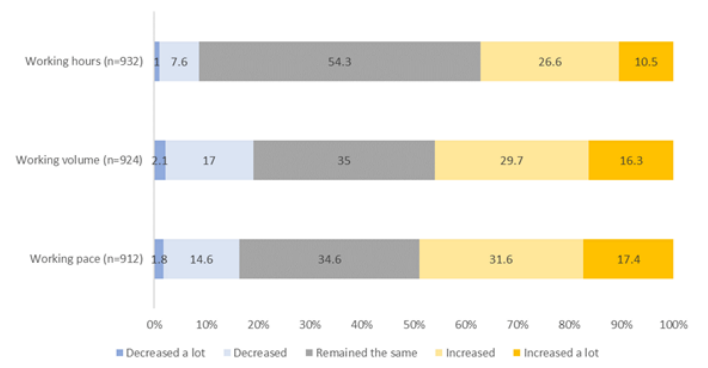
Figure 6: Changes on Working Time and Intensity Within Court Clerks (%)